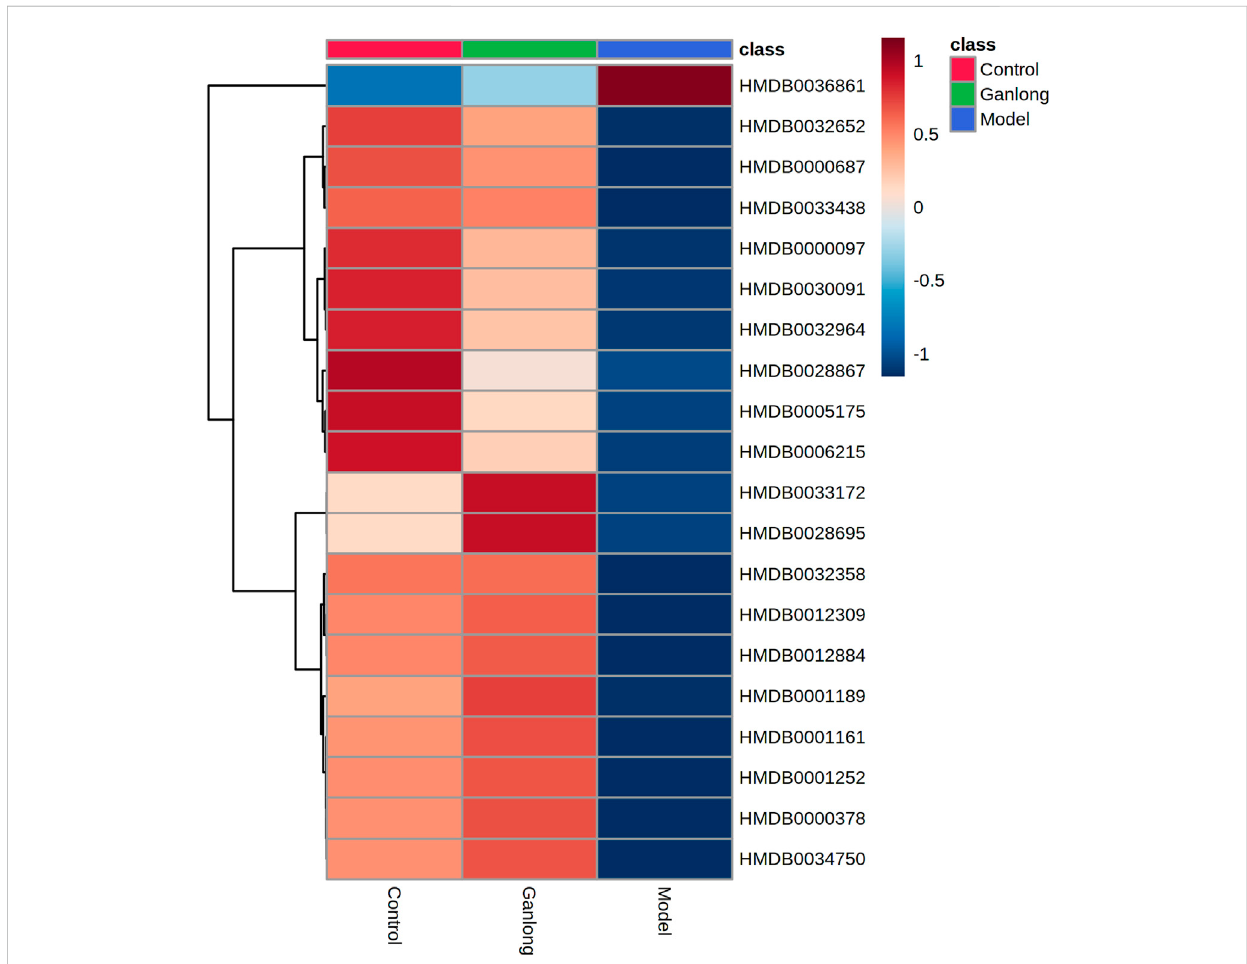
FIGURE 11 Heatmapofpotentialbiomarkerexpressioninurineofratsineachgroup.Controlgroup,modelgroupandGanlongcapsuletreatmentgroup( n =6).